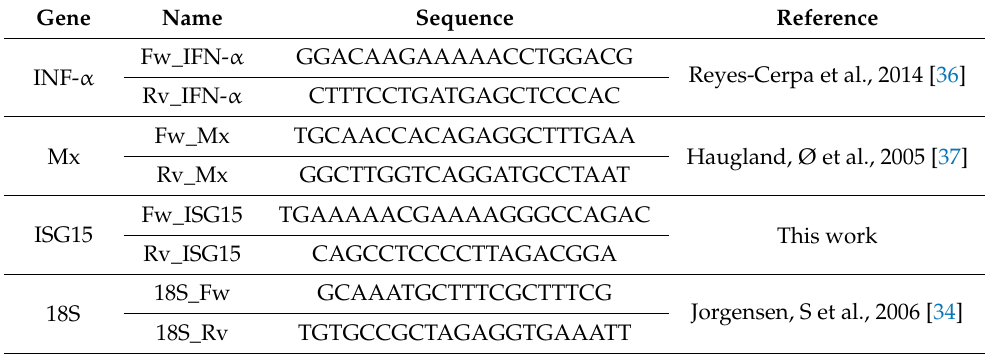
Table 3. Primers used for real-time qPCR